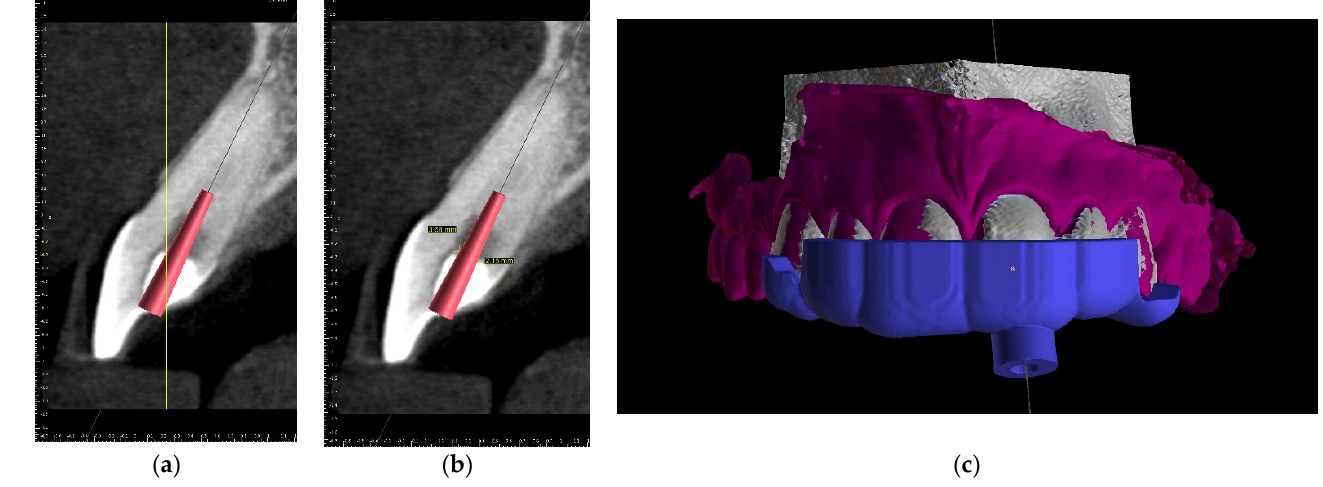
Figure 17. CBCT image showing ( a ) scheduled virtual implant position; ( b ) preserved tooth’s hard tissues in pericervical area around access pathway; ( c ) the extent of the endodontic guide that al- lowed us to place the rubber